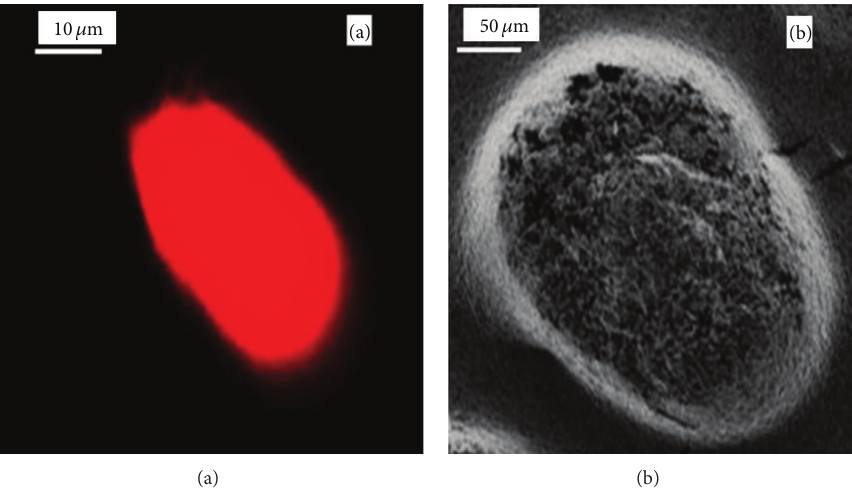
Figure 7: (a) Fluorescence image of bacteria and (b) SEM image of bacteria after being incubated with antibody conjugated silica